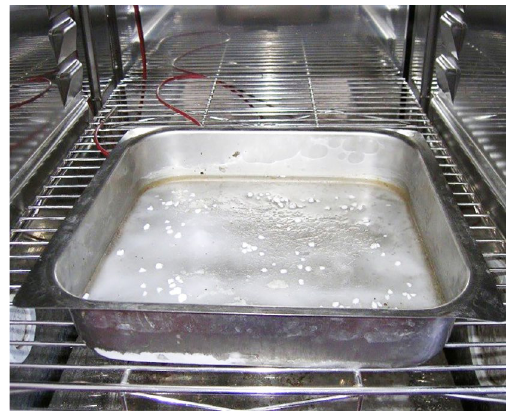
Fig. 3. Formed ice sample with an applied DM